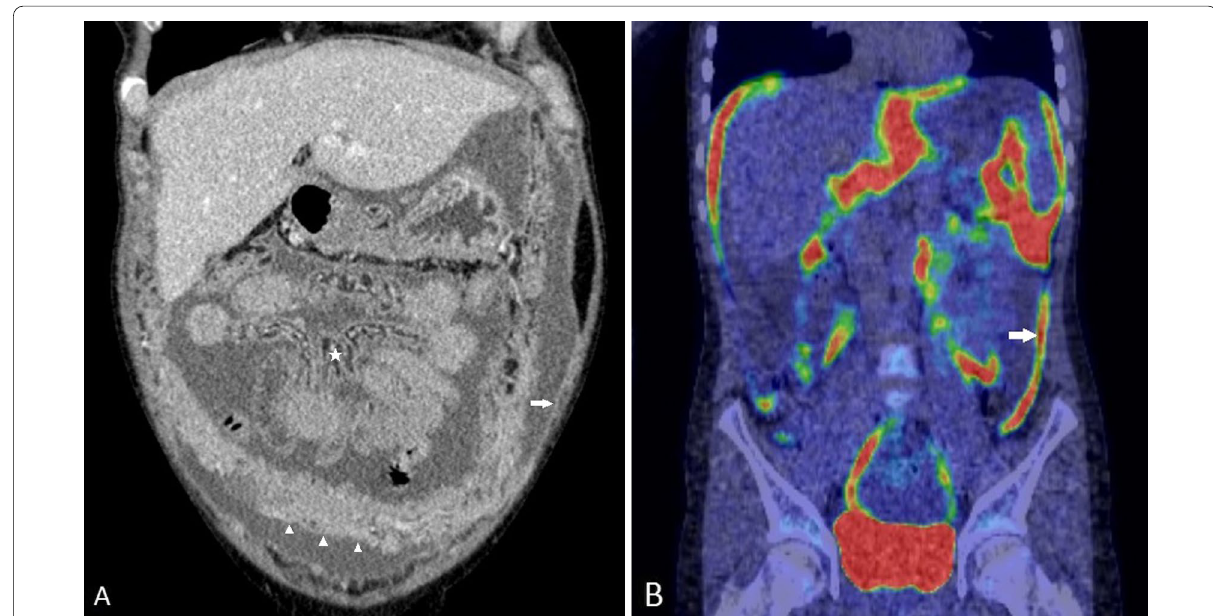
Fig. 7 a , b 47-year-old female with epithelioid type of malignant peritoneal mesothelioma. a Coronal CT image demonstrates diffuse plaque-like peritoneal thickening (white arrow), omental caking (arrow heads), ascites and tethered mesentery (*). b Coronal PET-CT shows FDG-avid plaque-like thickening (arrow) of the